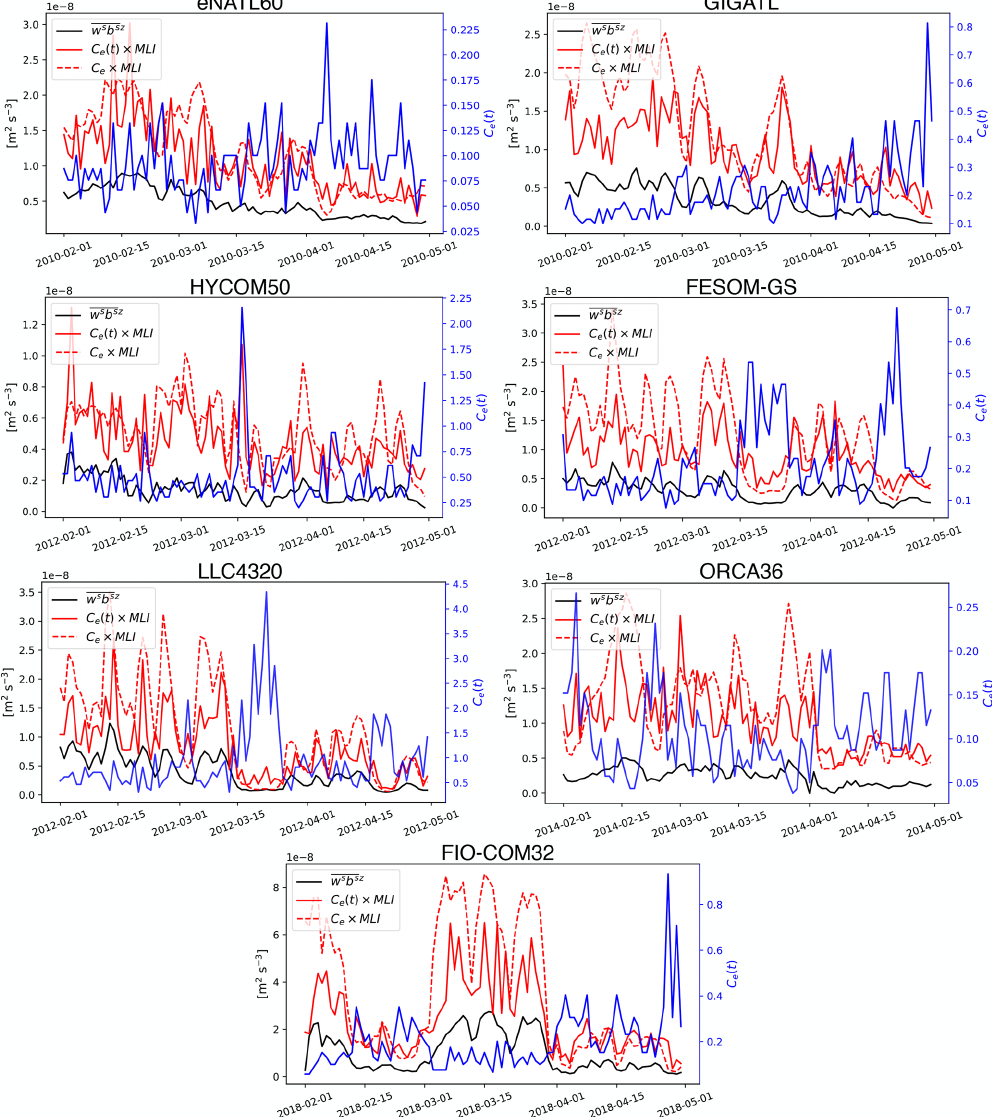
z (cid:105) ; black solid